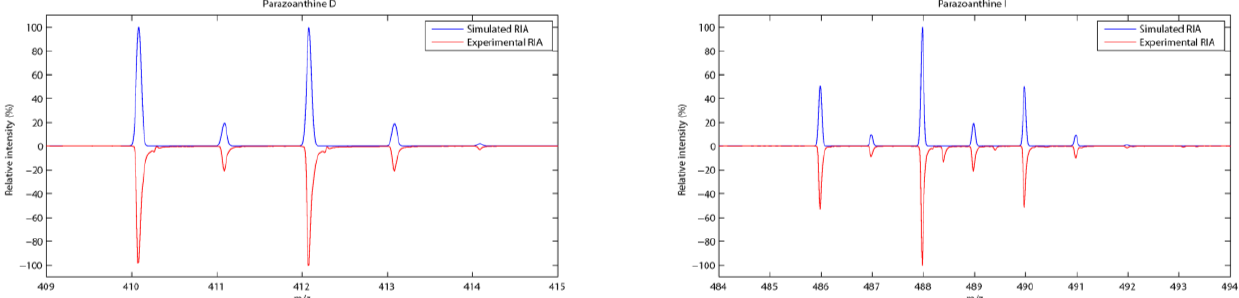
Figure 5. Relative isotopic abundance (RIA) of mono- and di-brominated compounds 4 ( left ) and 9 ( right